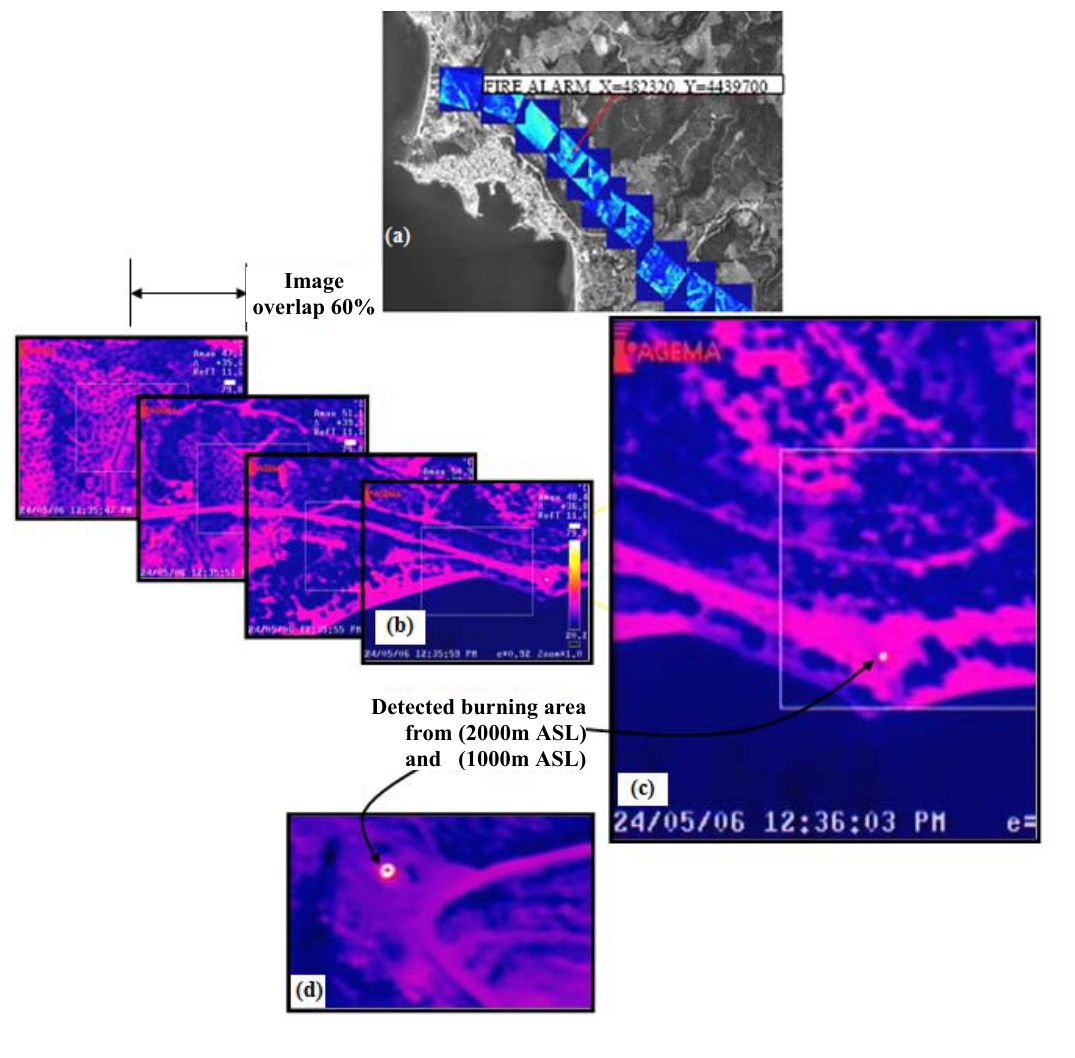
Figure 8 . The operation of the SITHON airborne imaging system on May 24, 2006 over the Sithonia peninsula: (a) and (b) dynamic surface viewing and image stereoscopic acquisition with 60% image overlap, (c) a 3x3 m 2 burning surface detected from 2,000 m ASL and (d) a 3x3 m 2 burning surface detected from 1,000 m